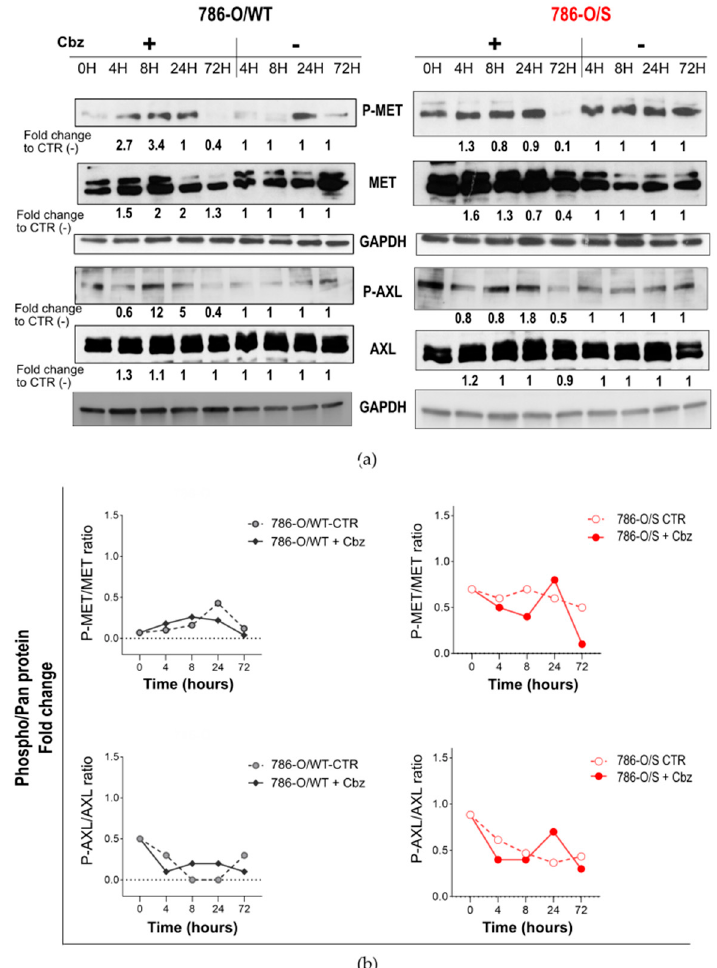
Figure 2. Effect of cabozantinib on signal transduction in human RCC treatment-naïve 786-O/WT cells and following long-term treatment with sunitinib in 786-O/S cells. ( a ) Cell lysates (20 µg) obtained from 786-O/WT and 786-O/S cells treated (+) with 12 µM of cabozantinib (Cbz) or untreated ( − ) with DMSO 0.1% at four time points were analyzed with an immunoblotting assay for specific antibodies with phosphorylated and total MET and AXL receptor proteins. GAPDH expression was selected as the loading control of samples for indicated proteins. The optical density (OD) of the area of each band was quantified with ImageJ-1.52a software and normalized to that of GAPDH. Numbers below each line represent the fold changes of the target proteins, which were obtained by dividing the normalized expression from each lane by the normalized expression of the relative untreated controls (set as 1). ( b ) Kinetics of MET (Y1234/5) and AXL (Y779) following treatment with cabozantinib (+Cbz) and in the untreated control (CTR) at indicated time points. Phosphorylation kinesis adjusted for total MET (P-MET/tot MET) and total AXL (P-AXL/tot AXL). Representative immunoblo tt ing image and relative quanti fi cation. Full-length blots of independent duplicates are provided in Supplementary Figures S2, S5 and S6. The fi gure was generated with Inkscape (version 1.0.2, RRID: SCR_014479).